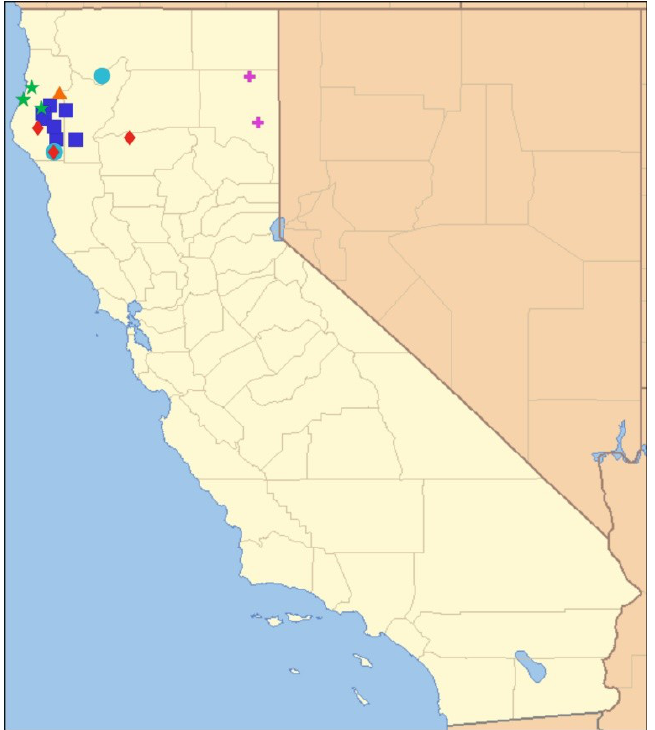
Figure 61. Distribution of Okanagana orythia (dark blue squares), O. vocalis (light blue circles), O. rhadine (orange triangle), O. salicola (red diamond), O. pernix (purple crosses) and O. sequoia (green